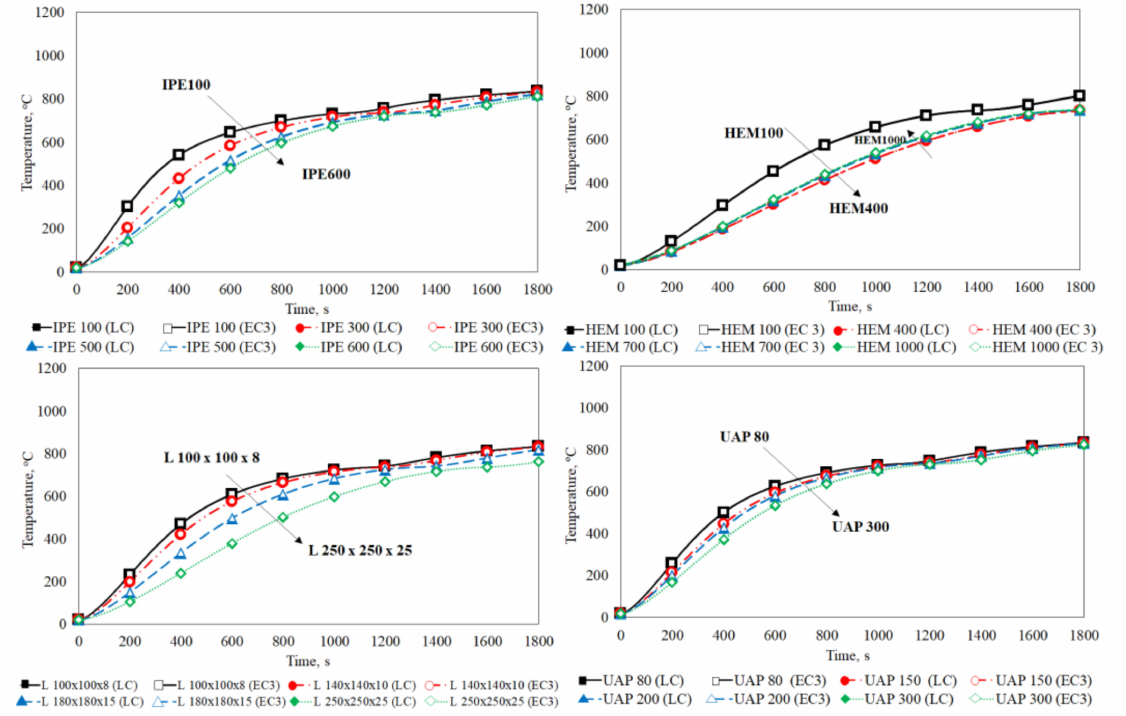
Figure 7. Temperature–time history of different profiles under ISO 834 curve. LC and EC3 are in